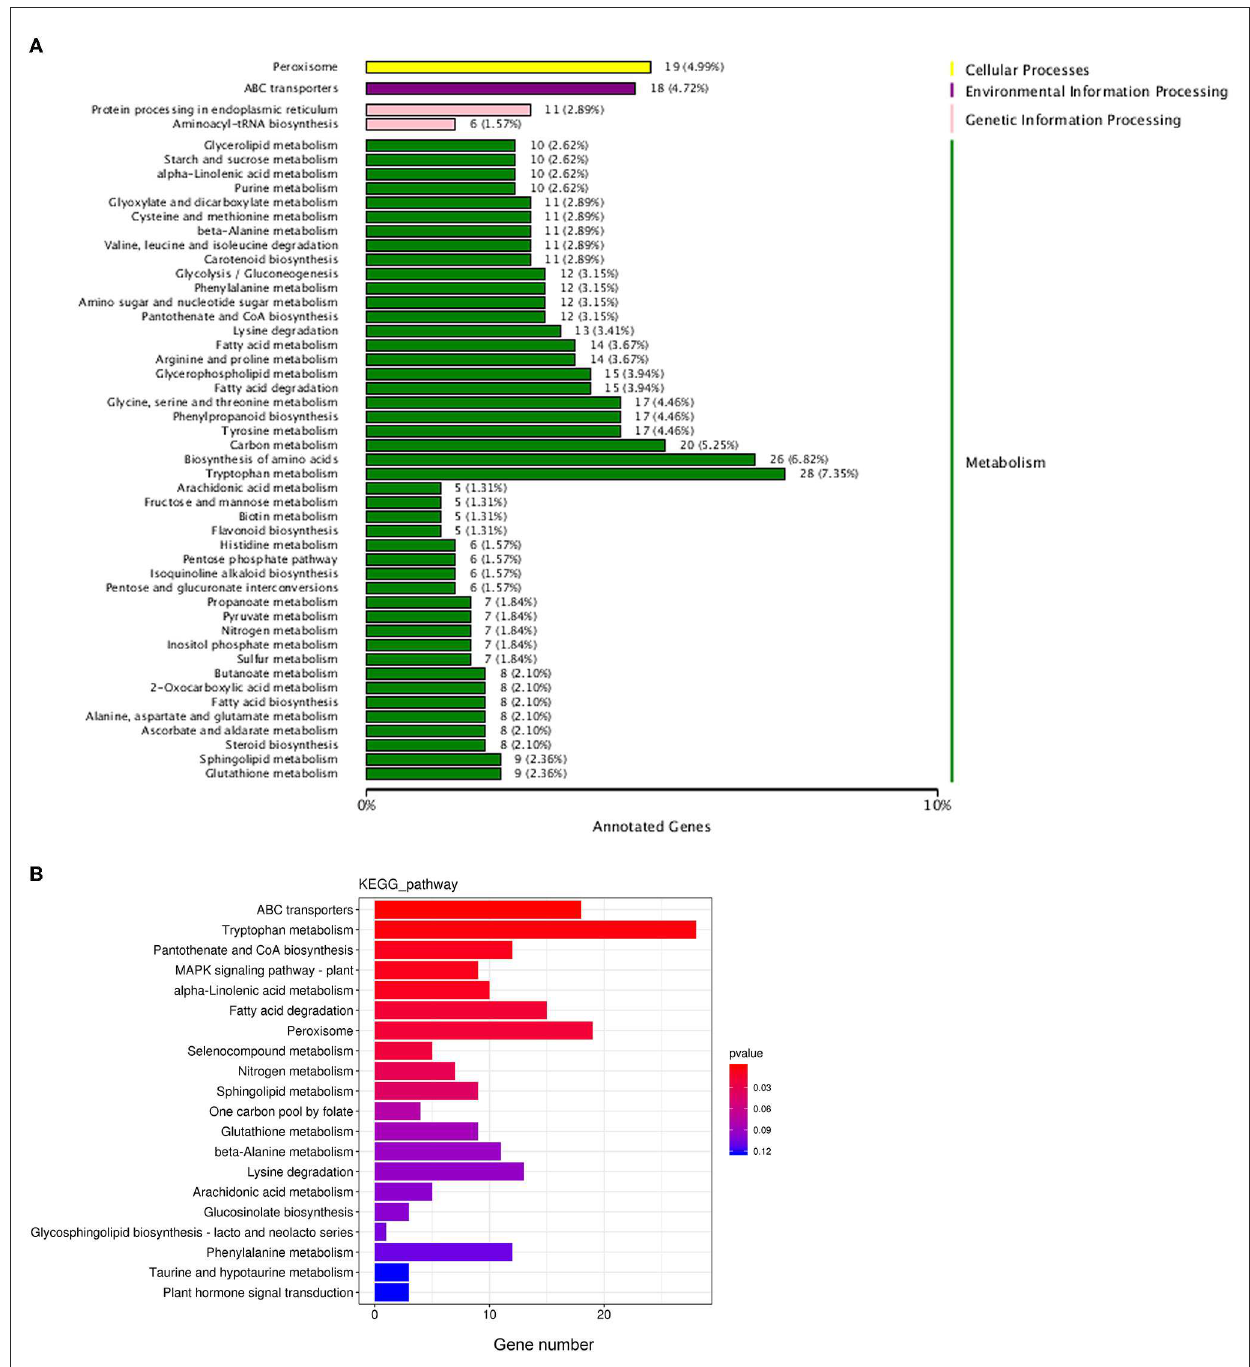
In addition, the clove EO showed a marked disruption of the cell wall and major organelles such as